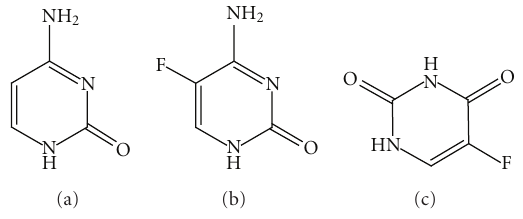
Figure 1: Chemical structures of cytosine (a) and of two fluoropy- rimidines, 5-fluorocytosine (b), and 5-fluorouracil (c).